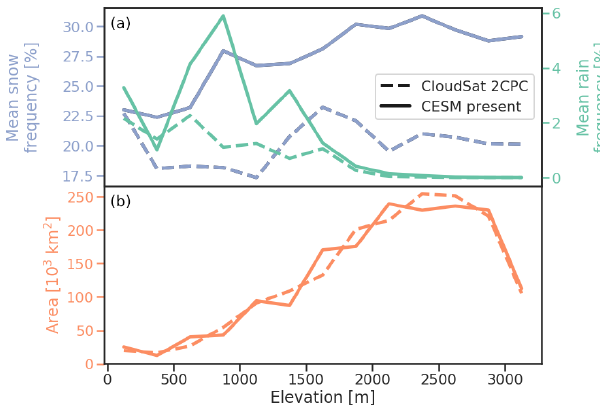
Figure 8. Comparison of GrIS hypsometry in GIMP (grey), Cloud- Sat regridded to GIMP (orange), CESM regridded to GIMP (green), and original CESM